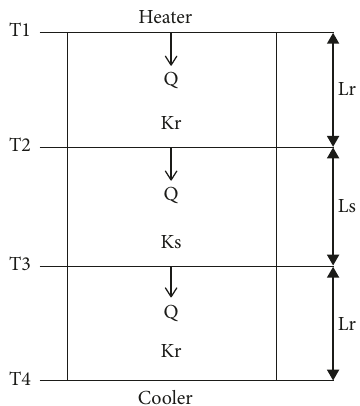
Figure 3: Positions of the reference and test specimens for thermal conductivity.